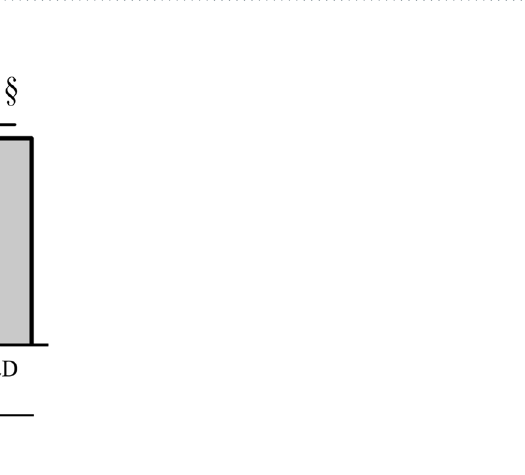
Table 1. Subject characteristics. BMI , Body Mass Index; BG , Basal Glycaemia; HbA1c , Glycated Haemoglobin; T2D , Type 2 diabetes; CS , control subjects; UT , untrained; TR , trained. ** p < 0.01 vs . UT, * p < 0.05 vs . UT. All values are shown as means ± SD.